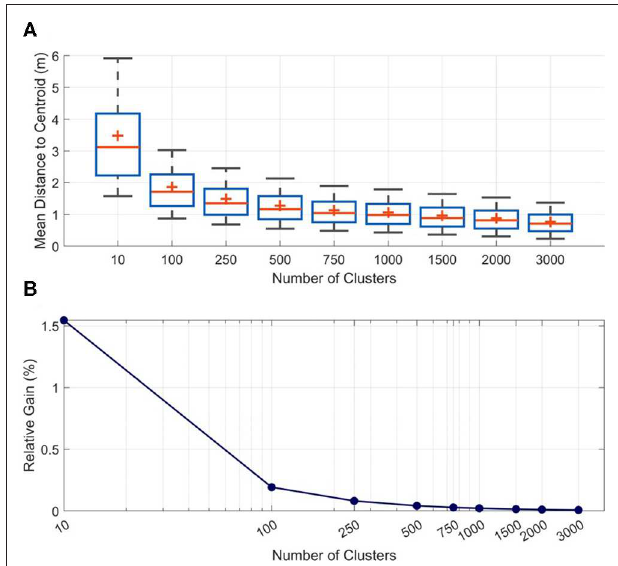
FIGURE 3 | (A) The distribution of the mean distance between a profile and its assigned centroid (iRCP) using K-medians for the varying number of tested cluster groups. (B) The relative gain in morphologic similarity of grouped profiles compared to the required XBeach Non-Hydrostatic (XBNH) model runs. This comparison is made to a reference case of all profiles being part of one cluster group, requiring 4 XBNH model runs. The relative gain is measured as the reduction in the mean distance between profiles and their centroid, divided by the additional required XBNH model runs, normalized to provide the result as a